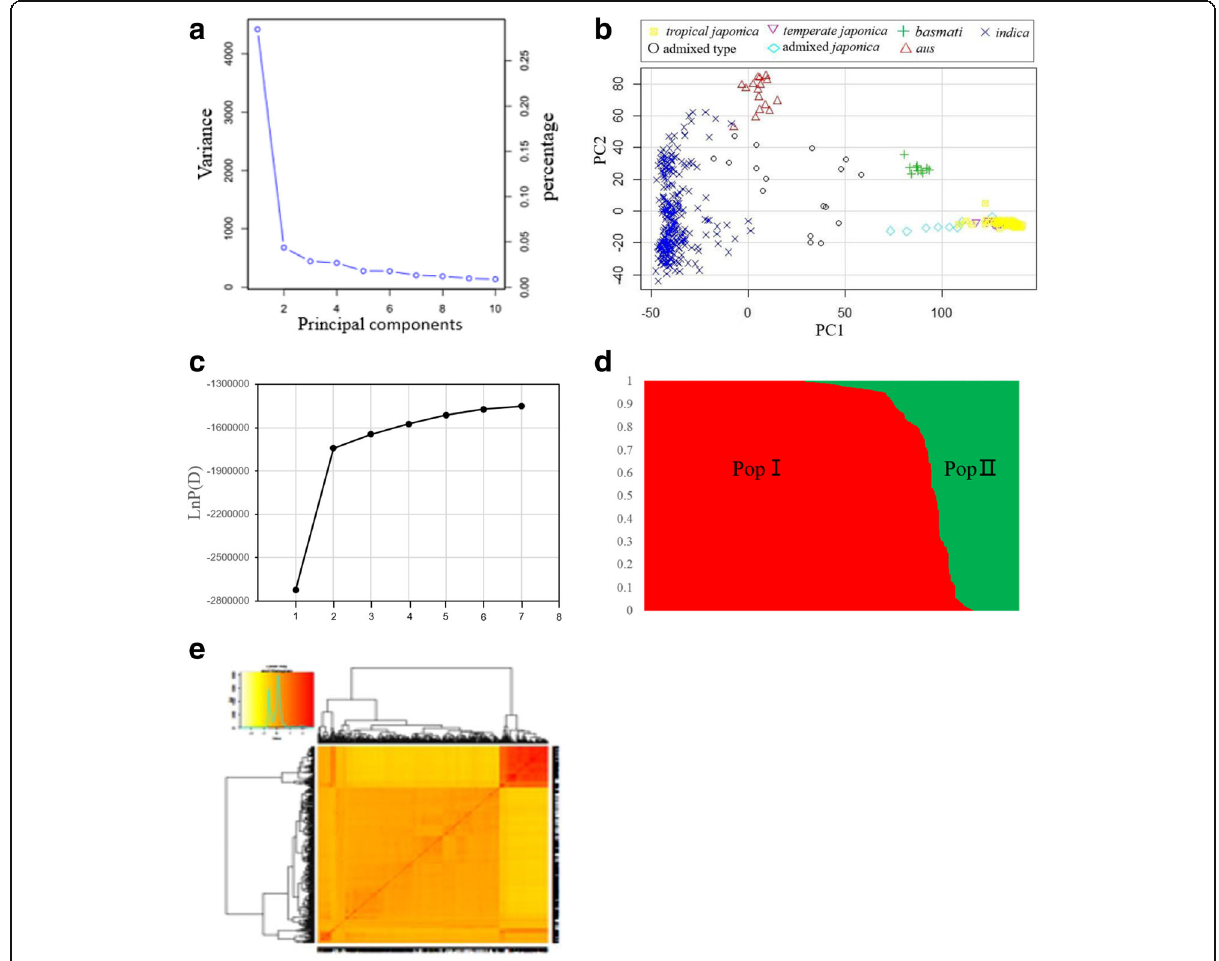
Fig. 2 a Screen plot from GAPIT showing the selection of PCs for association study. b PCA plot based on the screen plot in the rice diversity panel. c Screen plot from STRUCTURE showing the selection of Q. d Bayesian clustering of 423 accessions using STRUCTURE program. e Heat map of kinship from GAPIT with the tree shown on the top and